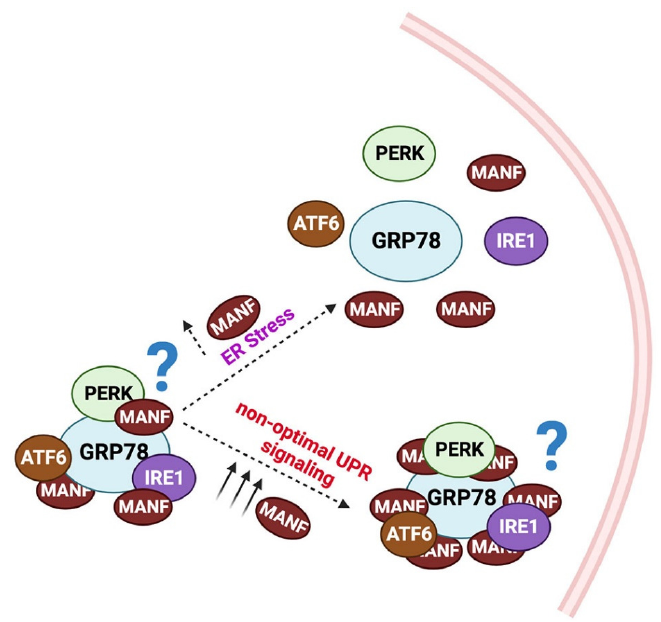
Figure 2. Potential mechanism for MANF-dependent UPR regulation: In the steady state, MANF binds to GRP78. The MANF-GRP78 interaction may stabilize the GRP78/PERK/IRE1 α /ATF6 complex. During ER stress, due to high-a ffi nity binding between GRP78 and KDEL receptors, MANF releases from the complex, and hence, the UPR transducers PERK/IRE1 α /ATF6. However, in uncontrolled UPR, increased MANF levels re-establish the GRP78/ PERK/IRE1 α /ATF6 complex and suppress UPR.